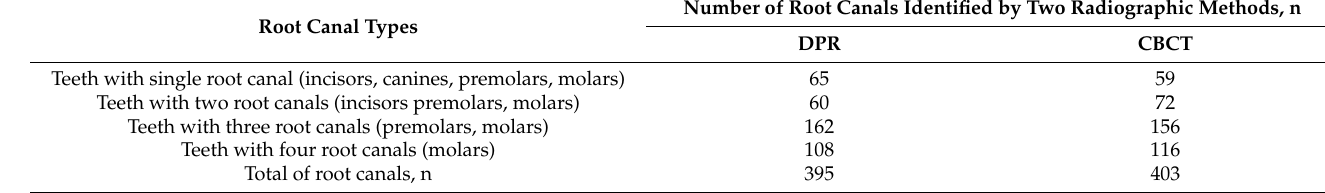
Table 1. Distribution of study sample by root canal type (N = 176 teeth).